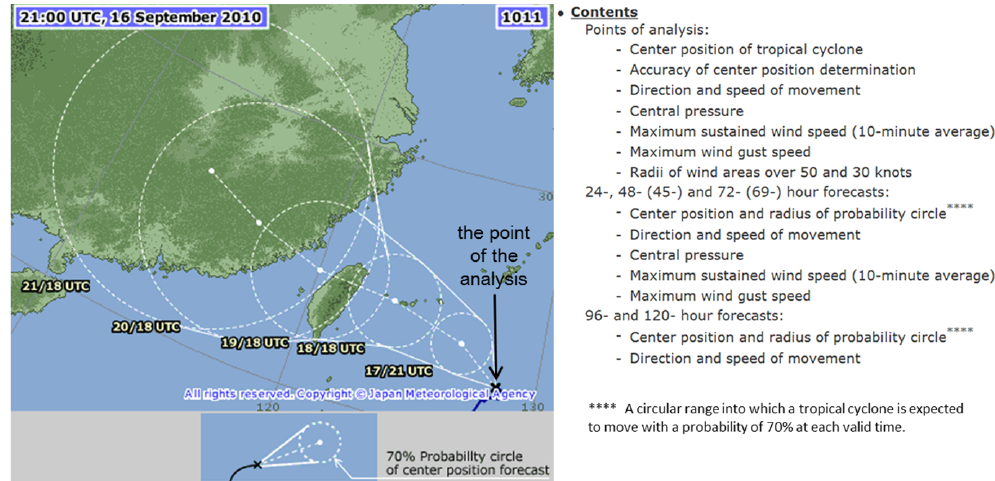
Figure 5. Tropical cyclone information from the Regional Specialized Meteorological Center (RSMC) Tokyo/Japan Meteorological Agency (JMA) (http://www.jma.go.jp/jma/jma-eng/jma-center/rsmc-hp-pub-eg/RSMC_HP.htm).